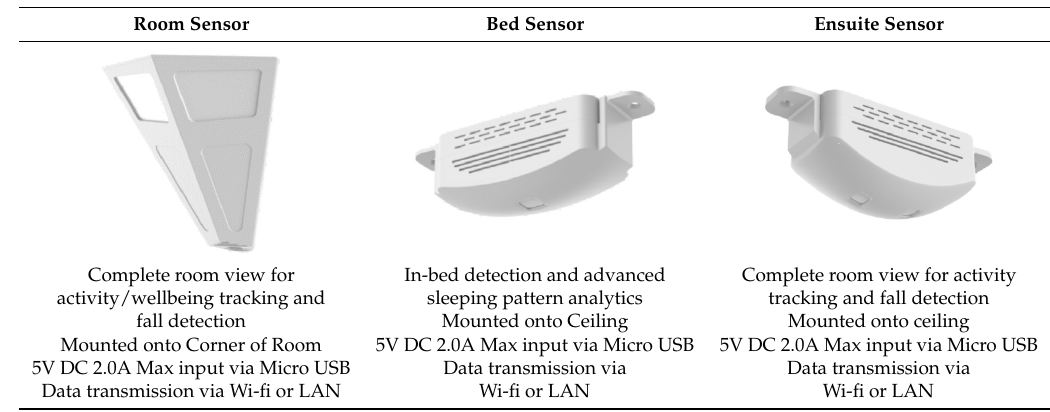
Table A6. Overview of Room